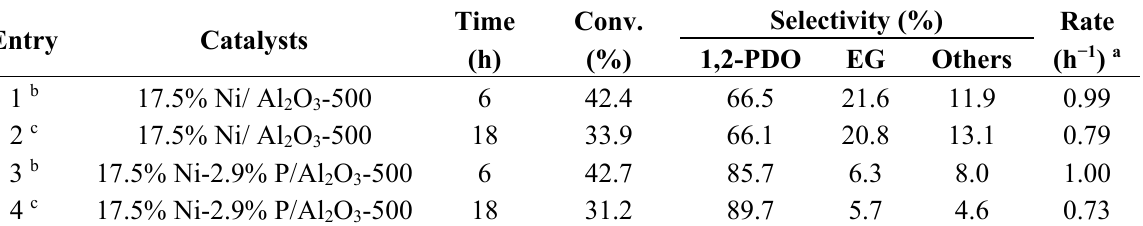
Table 4. The stability of the catalysts.